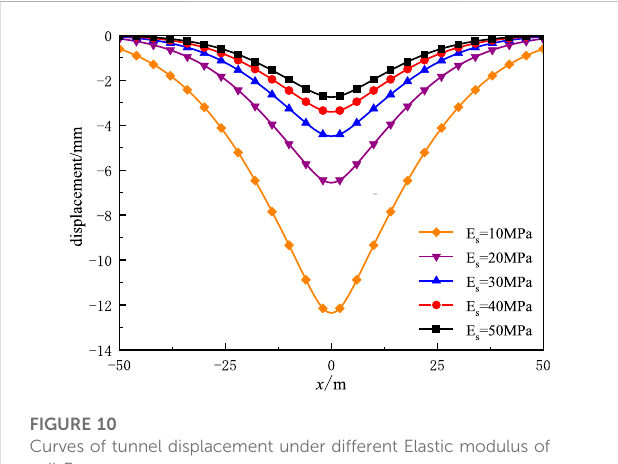
FIGURE 10 Curves of tunnel displacement under different Elastic modulus of soil E